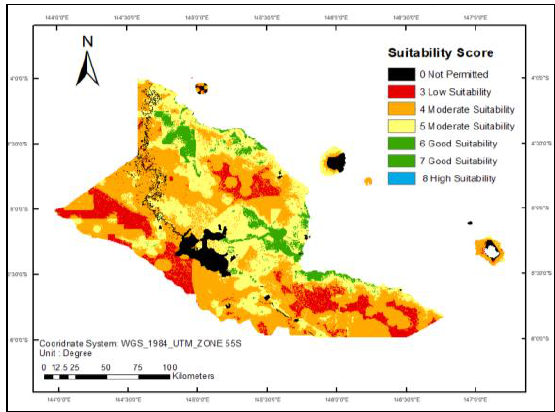
Figure 7. Industrial land-use suitability map with general AHP